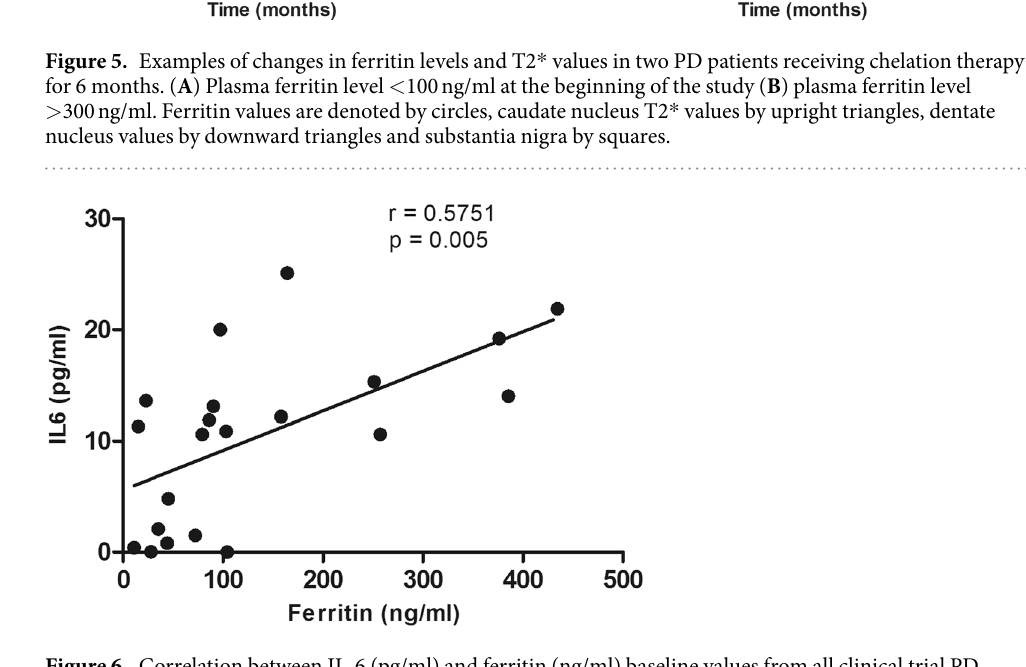
Figure 6. Correlation between IL-6 (pg/ml) and ferritin (ng/ml) baseline values from all clinical trial PD subjects. Statistical evaluation is by non-parametric correlation of Spearman (r = 0.5751, p =